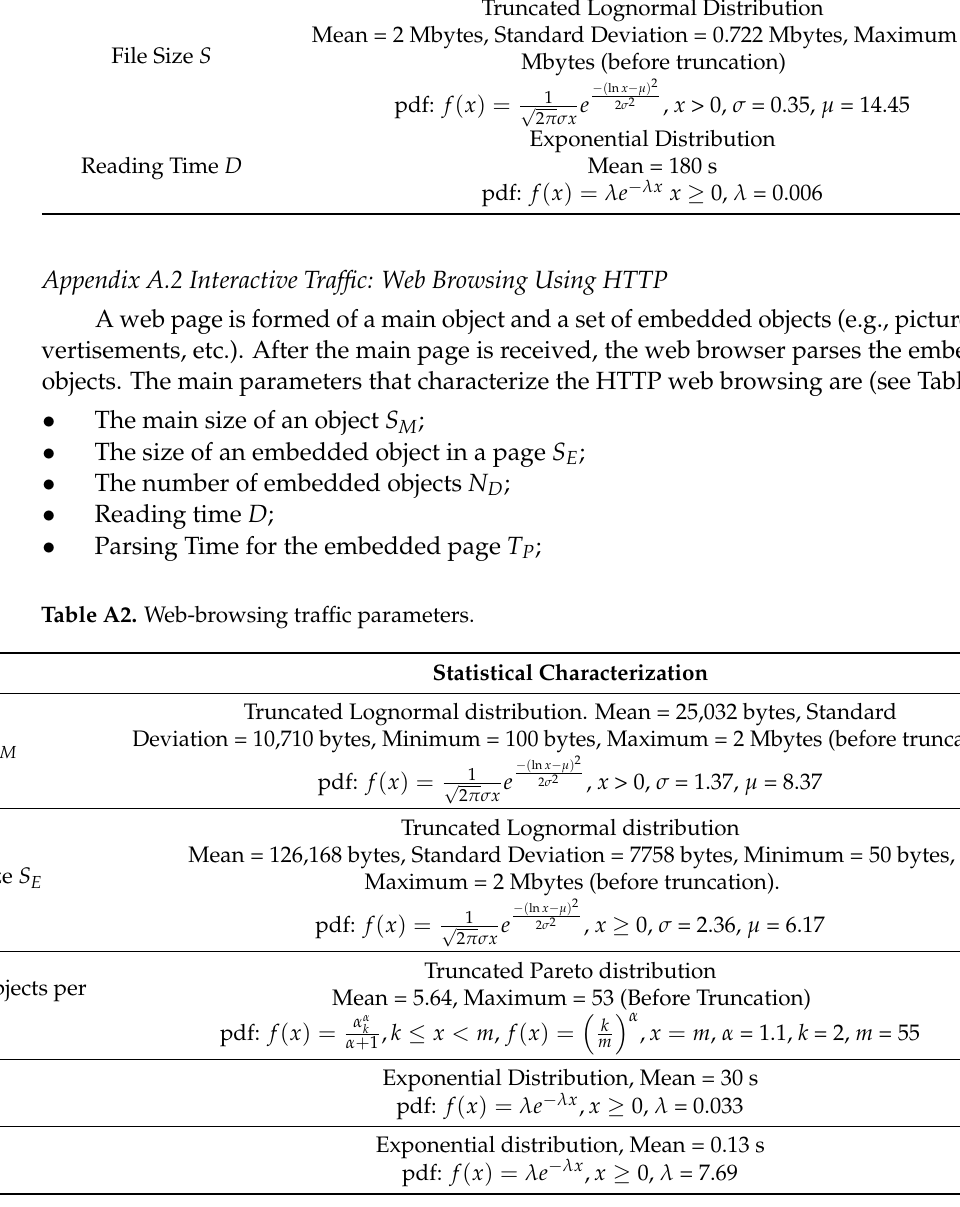
Table A1. FTP traffic parameters. Parameter